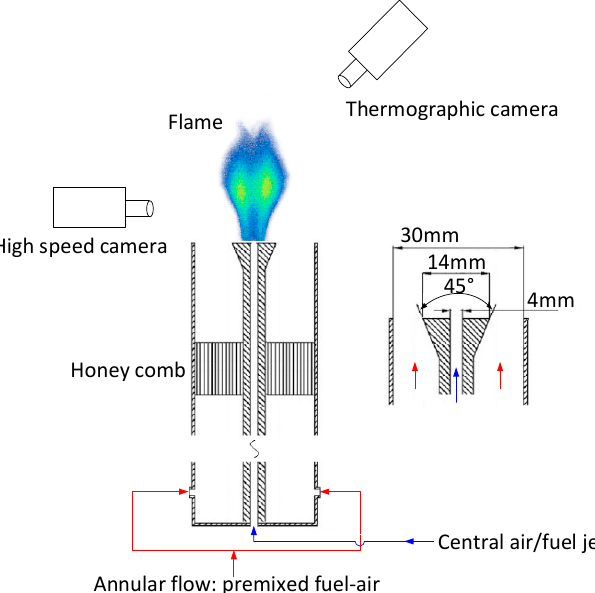
Annular flow: premixed Figure 2. A schematic of the experimental setup and the burner. Figure 2. A schematic of the experimental setup and the